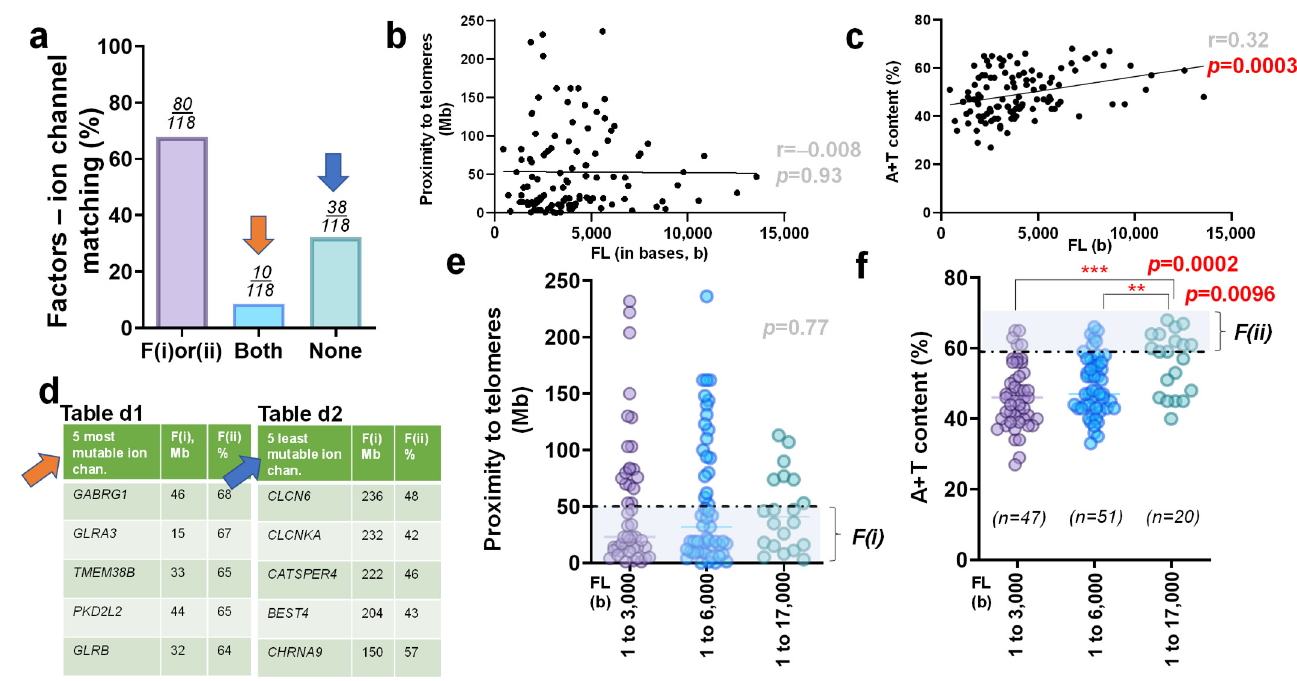
Figure 2. Relative mutability of druggable ion channels by two factors ( a ) Bar graph, which demon- strates the matching rate of genes encoding 118 druggable ion channels with both telomere proximity, F(i), and nucleotide composition, F(ii). Genes are sorted into three separate groups: those that satisfy one of the two factors, (F(i) or (ii)), those meeting both F(i) and F(ii) (Both, denoted with orange arrow), and those satisfying neither F(i) nor F(ii) (None, denoted with blue arrow) ( b ) Scatter plot showcasing the correlation between the full-length size of genes that encode ion channels and their proximity to telomeres. The Pearson correlation coefficient for this relationship is r = − 0.008, with a level of statistical significance of p = 0.93. ( c ) Scatter plot showcasing the correlation between the full length of genes that encode ion channels and their A+T content. The Pearson correlation coefficient for this relationship is r = 0.32, with a level of statistical significance of p = 0.0003. ( d ) The five primary candidates ( GABRG1, GLRA3, TMEM38B, PKD2L2, and GLRB ) that have been sorted as the genes with relatively high mutability (the ‘Both’ group; Table d1). Five alternative candidate genes ( CLCN6, CLCNKA, CATSPER4, BEST4 , and CHRNA9 ), which have been sorted as the genes with relatively low mutability (the ‘None’ group; Table d2). ( e ) Scatter plot showcasing the proximity to telomeres of genes encoding 118 ion channels with respect to three sub-groups, which were determined by the full-length size of the gene (unit: base or b). The dotted horizontal line demarcates 50 Mb. After one-way ANOVA, no significant differences ( p = 0.77) were found. ( f ) Scatter plot demonstrating the A+T content of genes encoding 118 ion channels with respect to the full-length of each gene. The dotted horizontal line demarcates 59%. Significant statistical differences were determined between the shortest (1 to 3000 bp) and longest size group (6001 to 17,000 bp) at p = 0.0002, as well as the intermediate (3001 to 6000 b) vs. the longest size group (6001 to 17,000 b) at p = 0.0096, respectively. **, p < 0.01; ***, p <